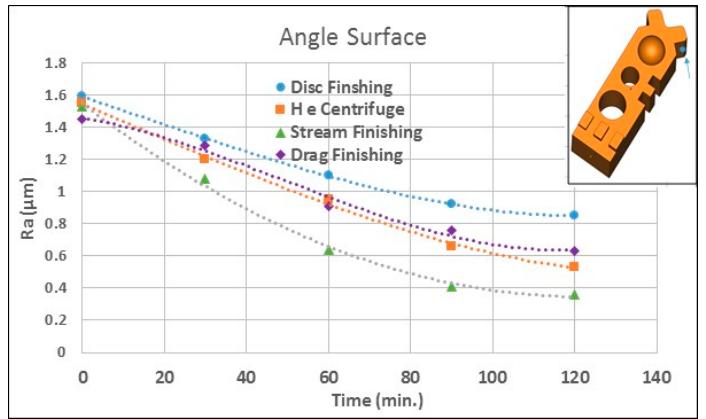
Figure 11. Surface roughness comparison on side surface (blue arrows show direction of measurement).